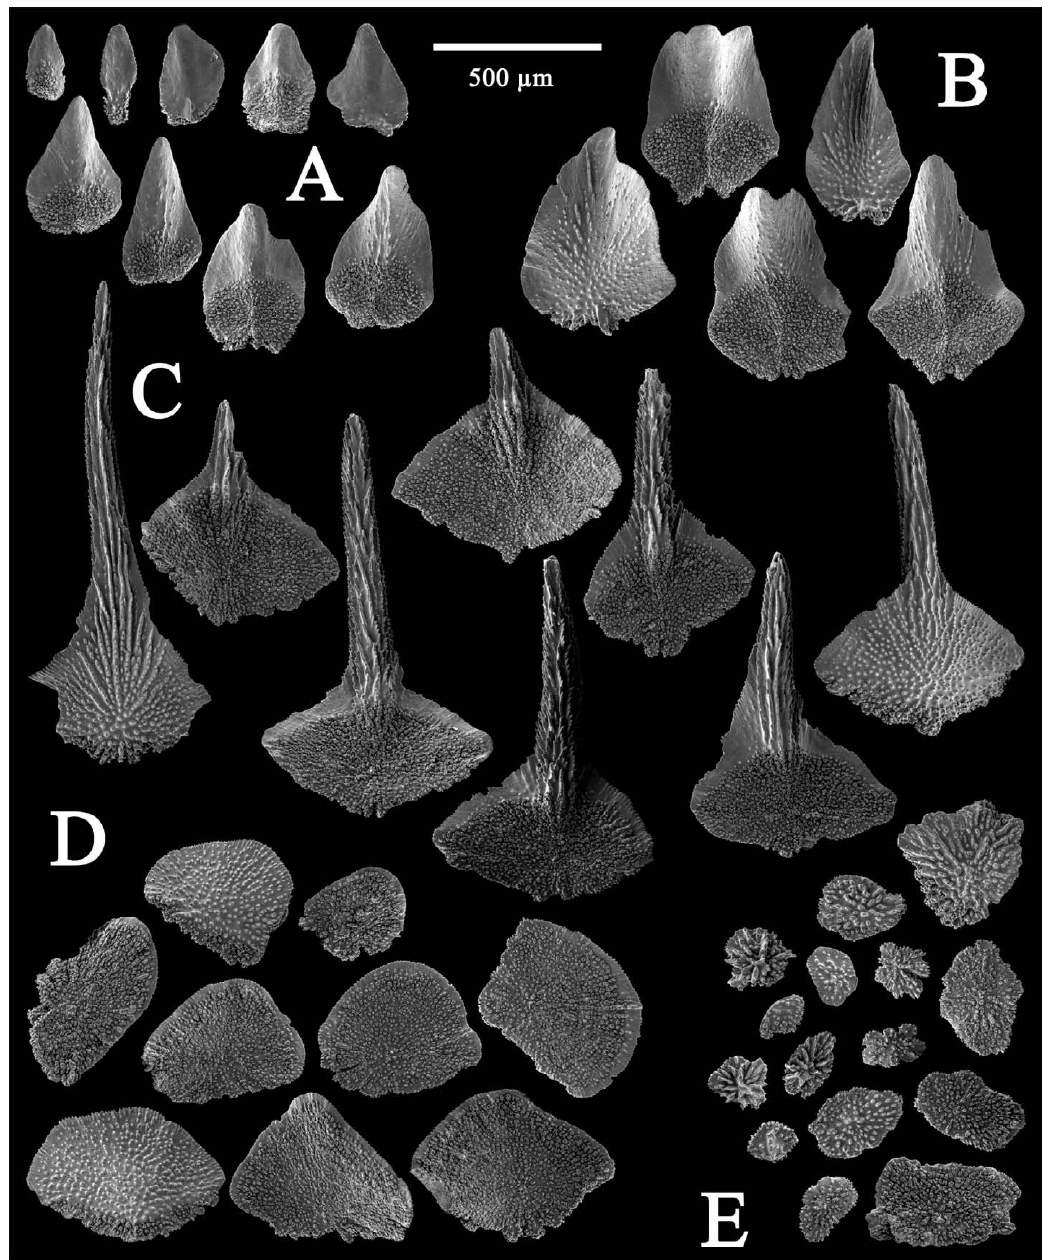
Fig . 10. – Thouarella undulata n. sp., holotype ZiZMH c11742: opercular scales from inner (a) and outer (b) alternate cycle. Marginal scales (c). body scales (d). coenenchymal scales